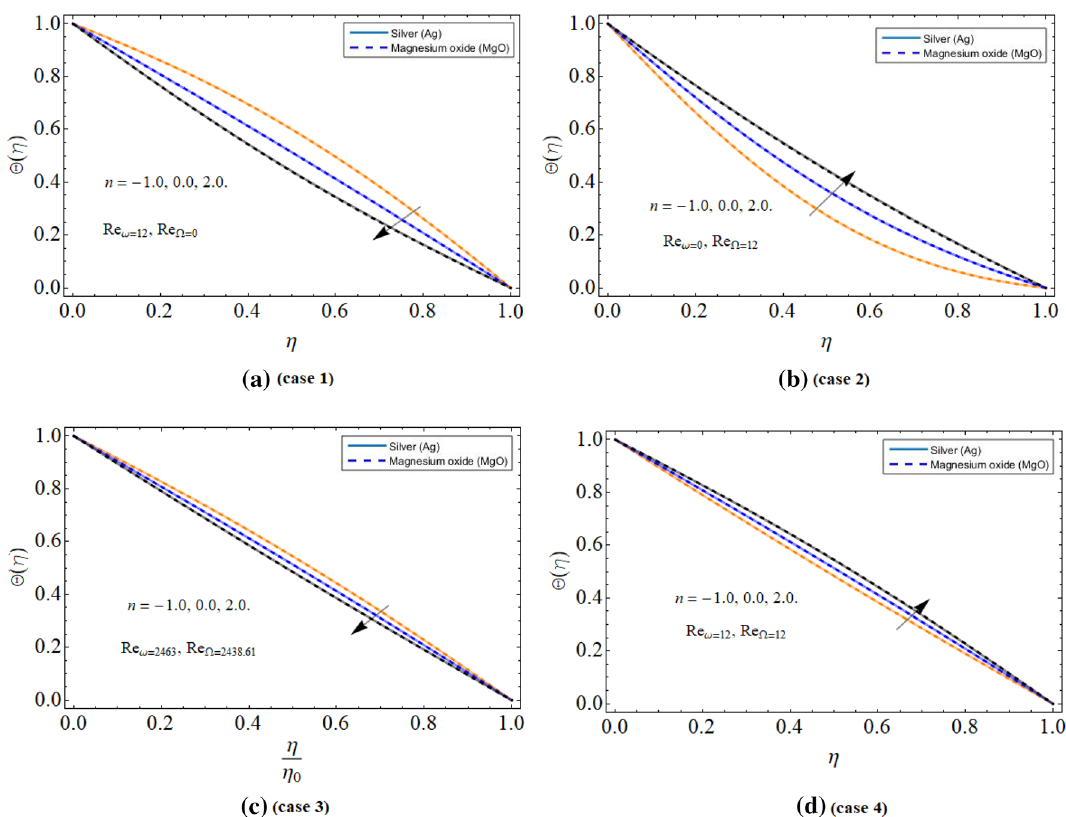
Figure 6. The behavior of thermal energy profile �(η) versus ( a ) disk rotation ( b ) cone rotation ( c ) both disk and cone co-rotation ( d ) both disk and cone